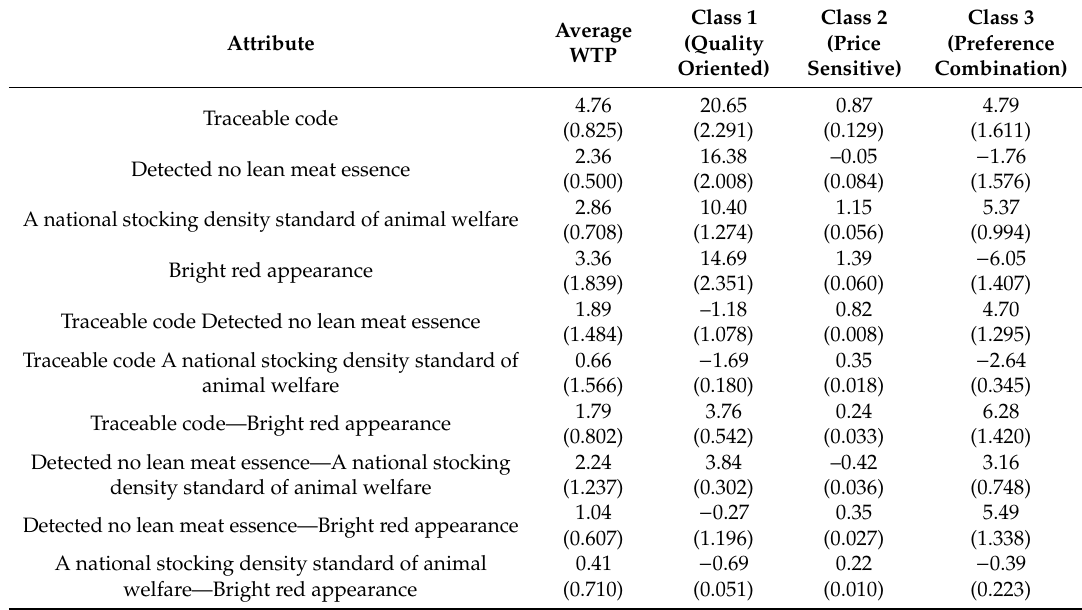
Table 6. Consumer willingness to pay (WTP) for each attribute, estimated by the RPL and LCM models (yuan / 500